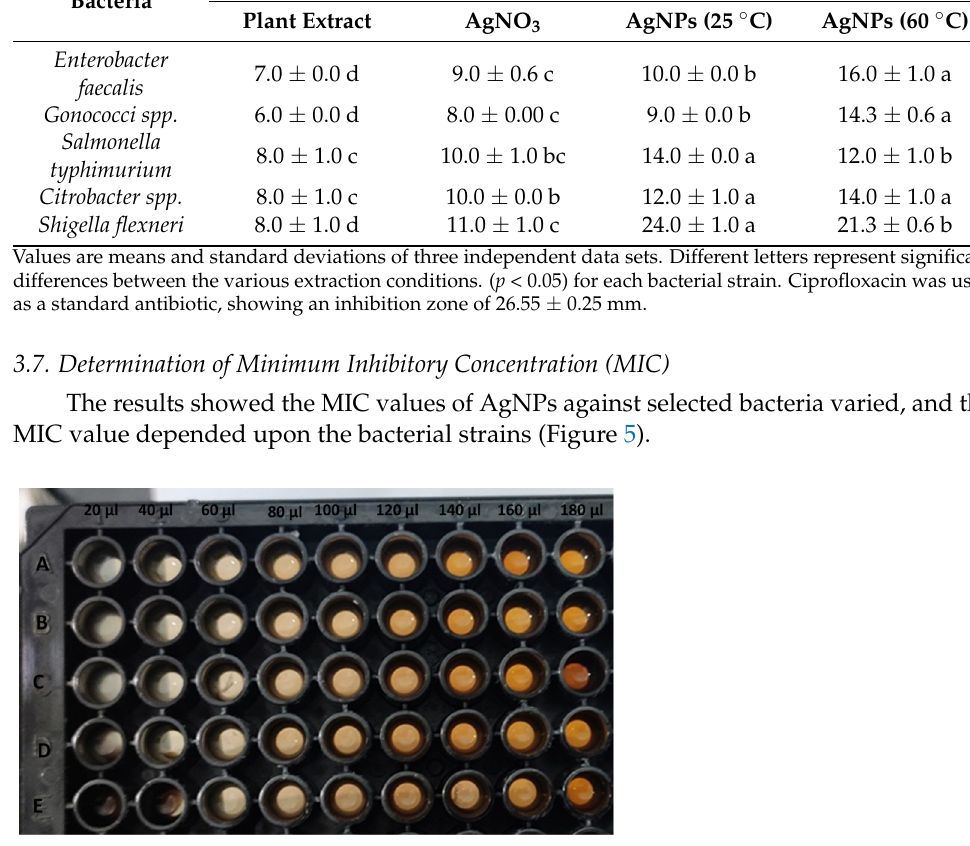
Table 2. Bacterial growth inhibition potential of biosynthesized AgNO 3 from C. carandas leaf extract. Bacteria